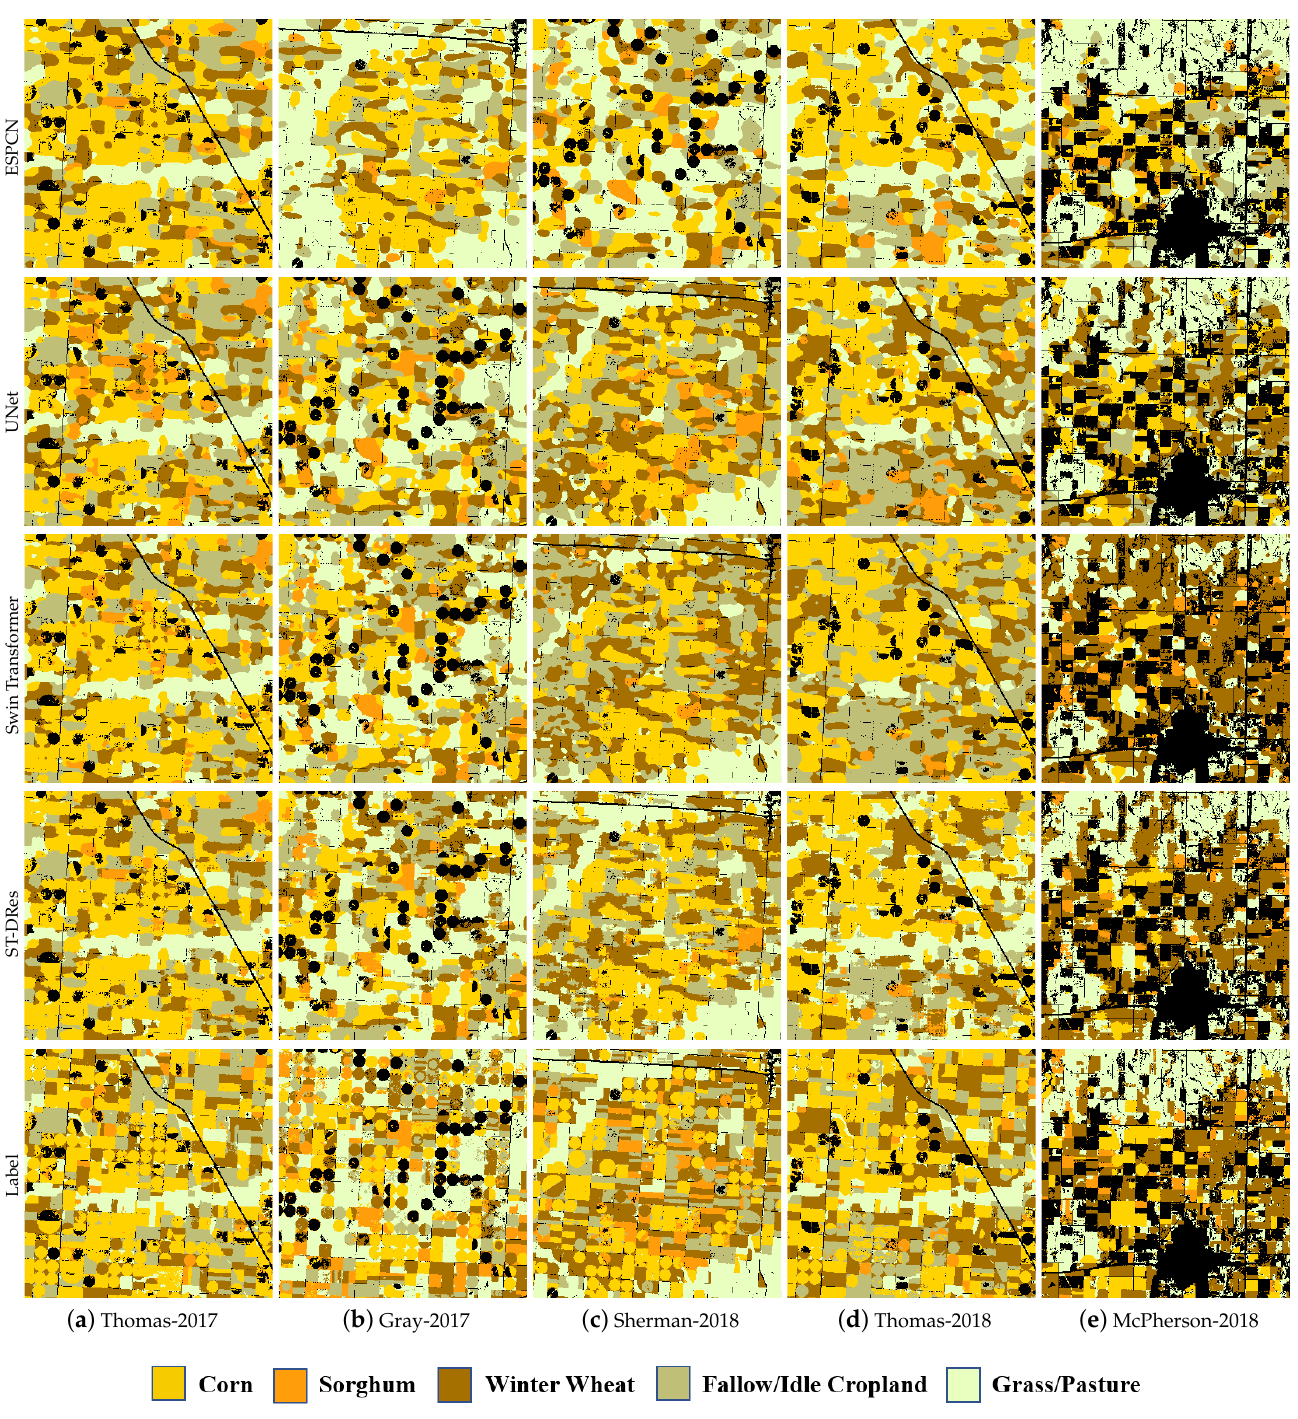
Figure 8. SPM results of small examples (320 × 320) in different spatial and temporal generalization experiments of different methods are displayed. The rows of “( a ) Thomas-2017” and “( b ) Gray-2017” represent the results of training in Sherman County in 2017 and testing in Thomas County and Gray County in 2017, respectively. The rows of “( c ) Sherman-2018”, “( d ) Thomas-2018”, and “( e ) McPherson-2018” represent the results of training in Sherman County in 2017 and testing in Sherman County, Thomas Count, and McPherson County in 2018,